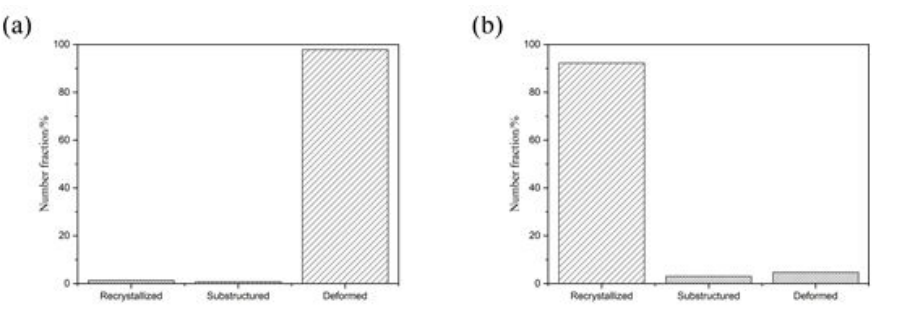
Figure 9. Diagram of microstructure, recrystallization, and large deformation grain number of Al/Mg composite plate: ( a ) Al, ( b ) Mg.